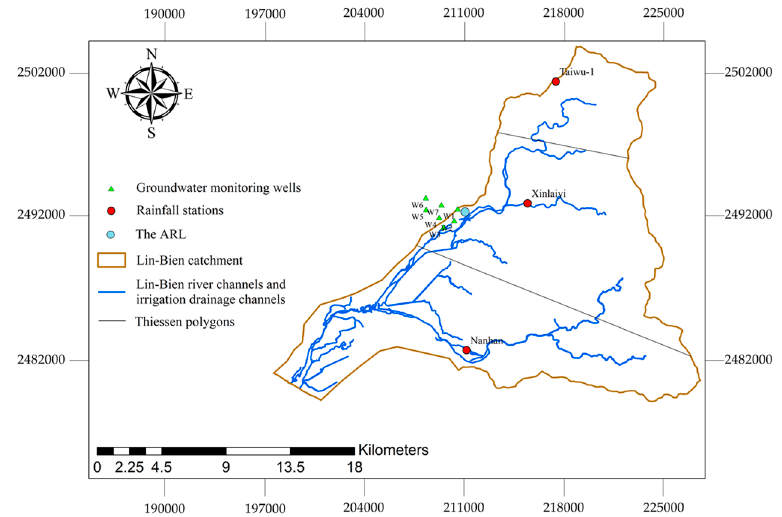
Figure 1. Location map of Pingtung Plain, after [22].